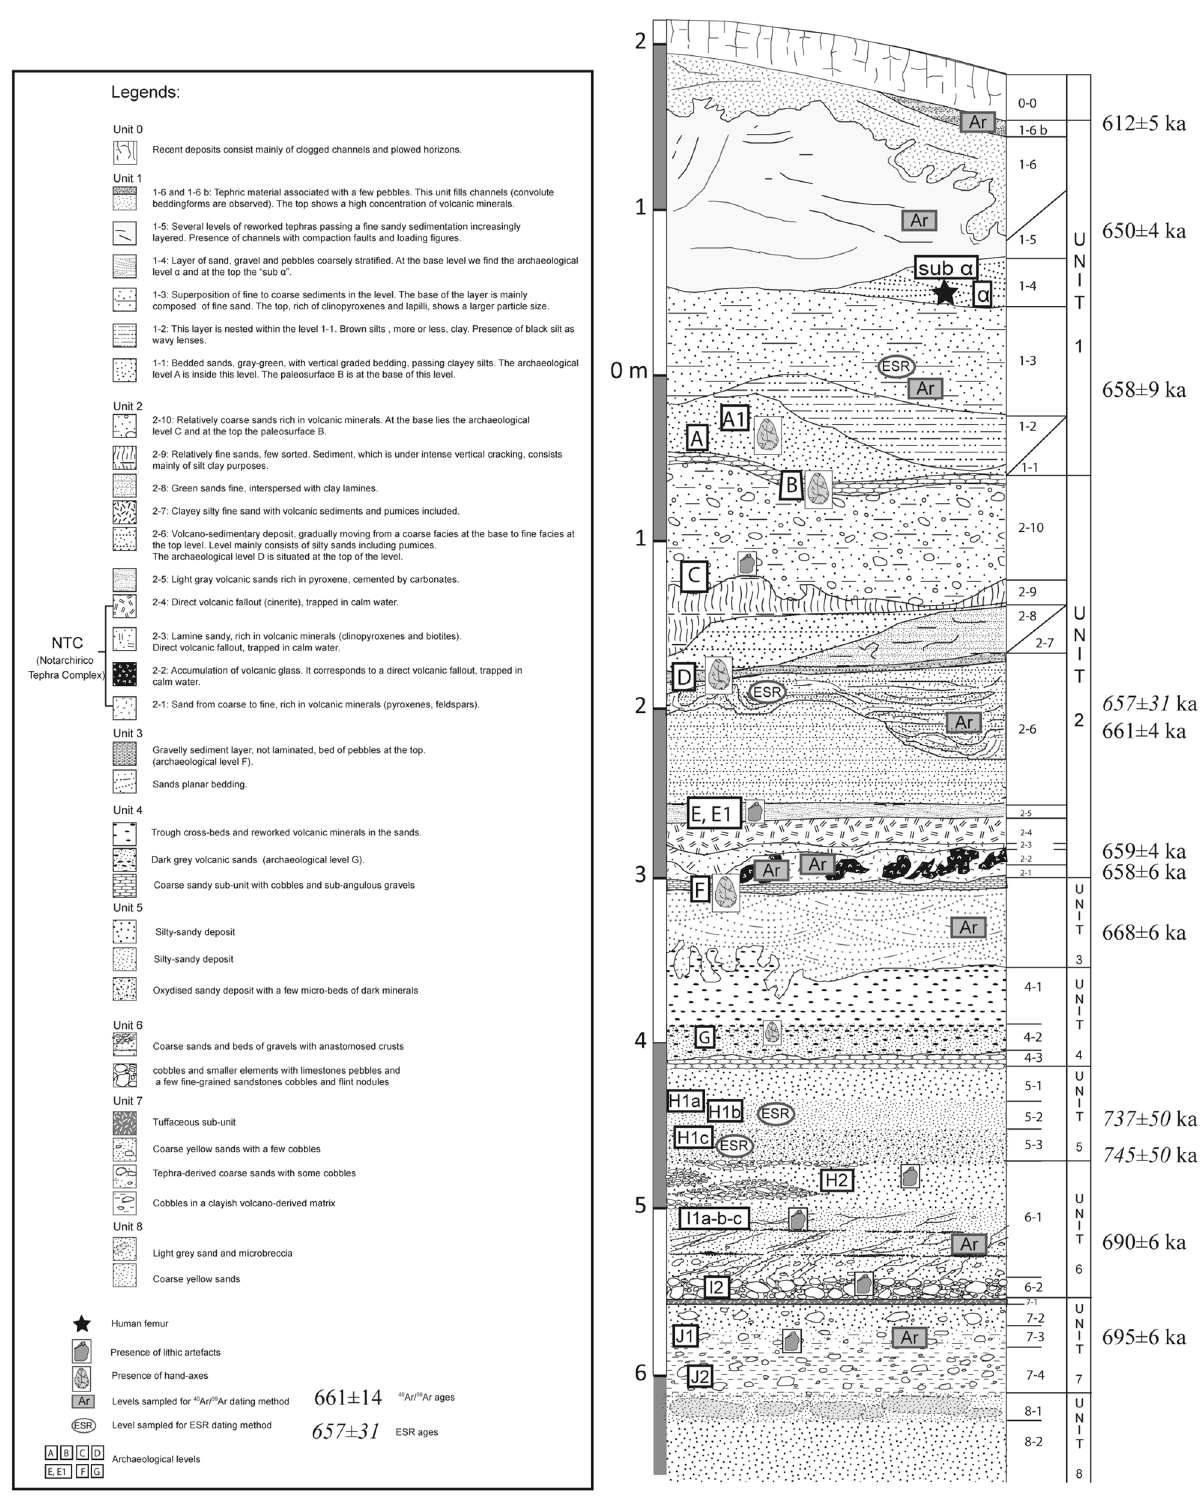
Figure 2. Stratigraphic log of the Notarchirico sequence (Modified from Raynal et al., 1999) with the 40Ar/39Ar and ESR dates on bleached quartz and the location of the phases of human occupation (with or without bifaces). The new fieldwork concerns the base of the sequence from layers F to J2. (Modified after J-P. Raynal and A. Pereira, by P. Voinchet and M-H.